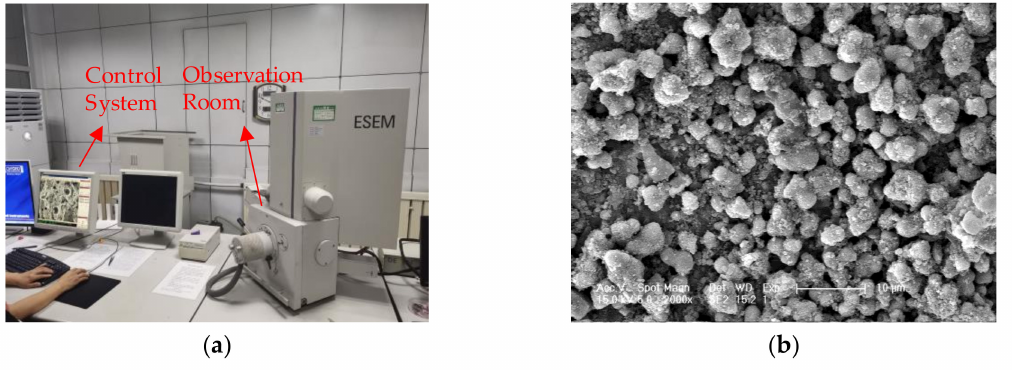
Figure 6. The environmental scanning electron microscope (ESEM) equipment and sample microscopic picture: ( a ) ESEM equipment; ( b ) sample microscopic